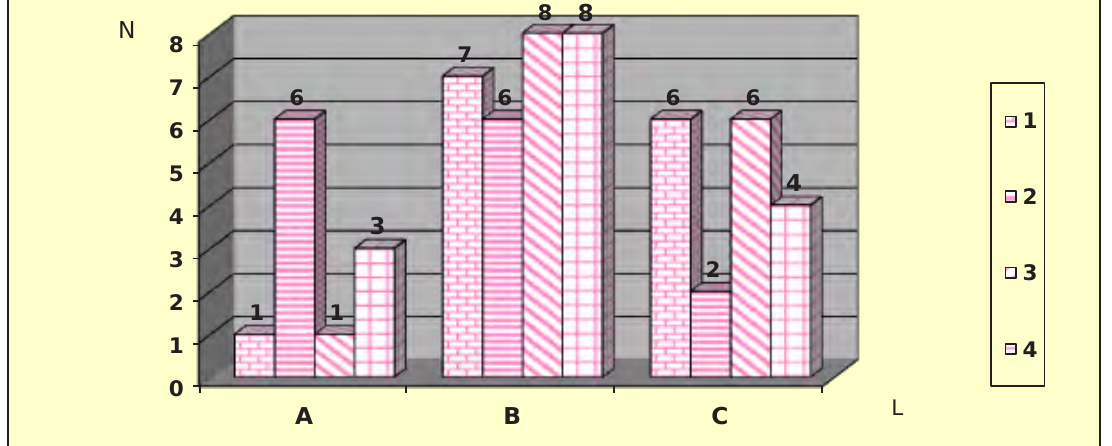
Fig 2. Results of a comparative analysis of EG and CG for the intensive indicator: 1 – EG in the preliminary stage, 2 – EG in the control stage, 3 – CG in the preliminary stage, 4 – CG in the control stage, A – high level, B – middle level, C – low level, D – level, N – number.